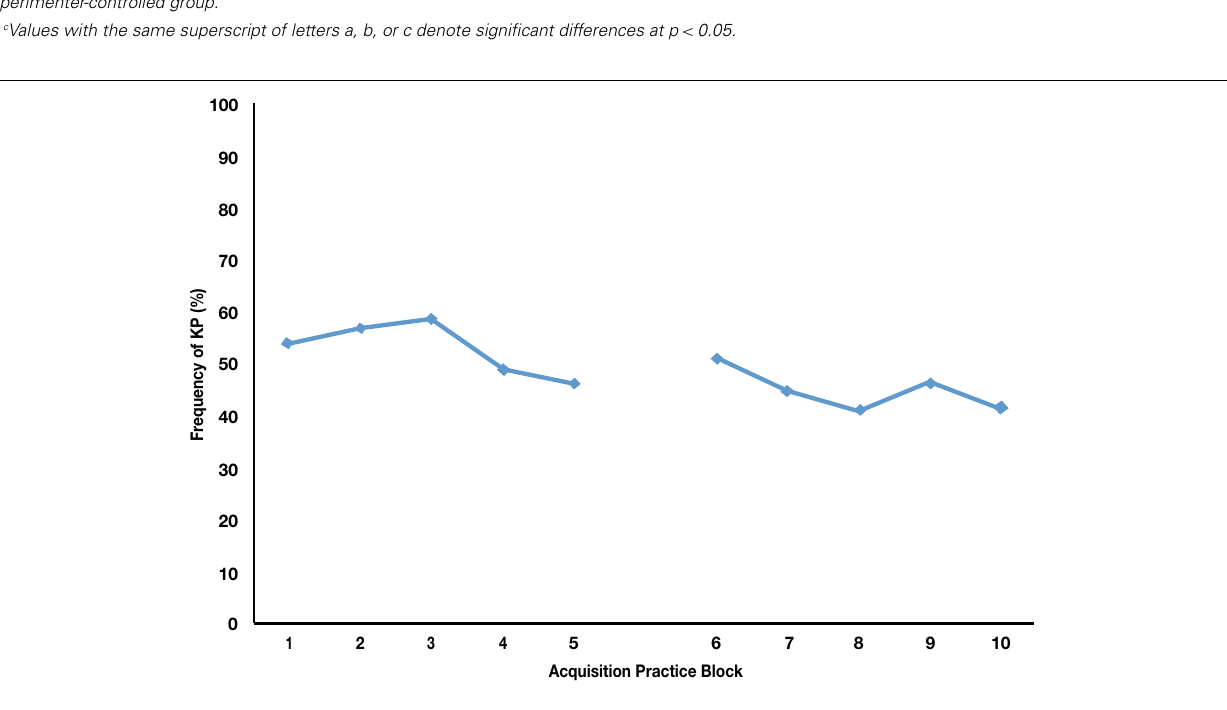
FIGURE 2 | Frequency of knowledge of performance (KP) requested by participants in the learner-controlled group across days 1 and 2 of the acquisition